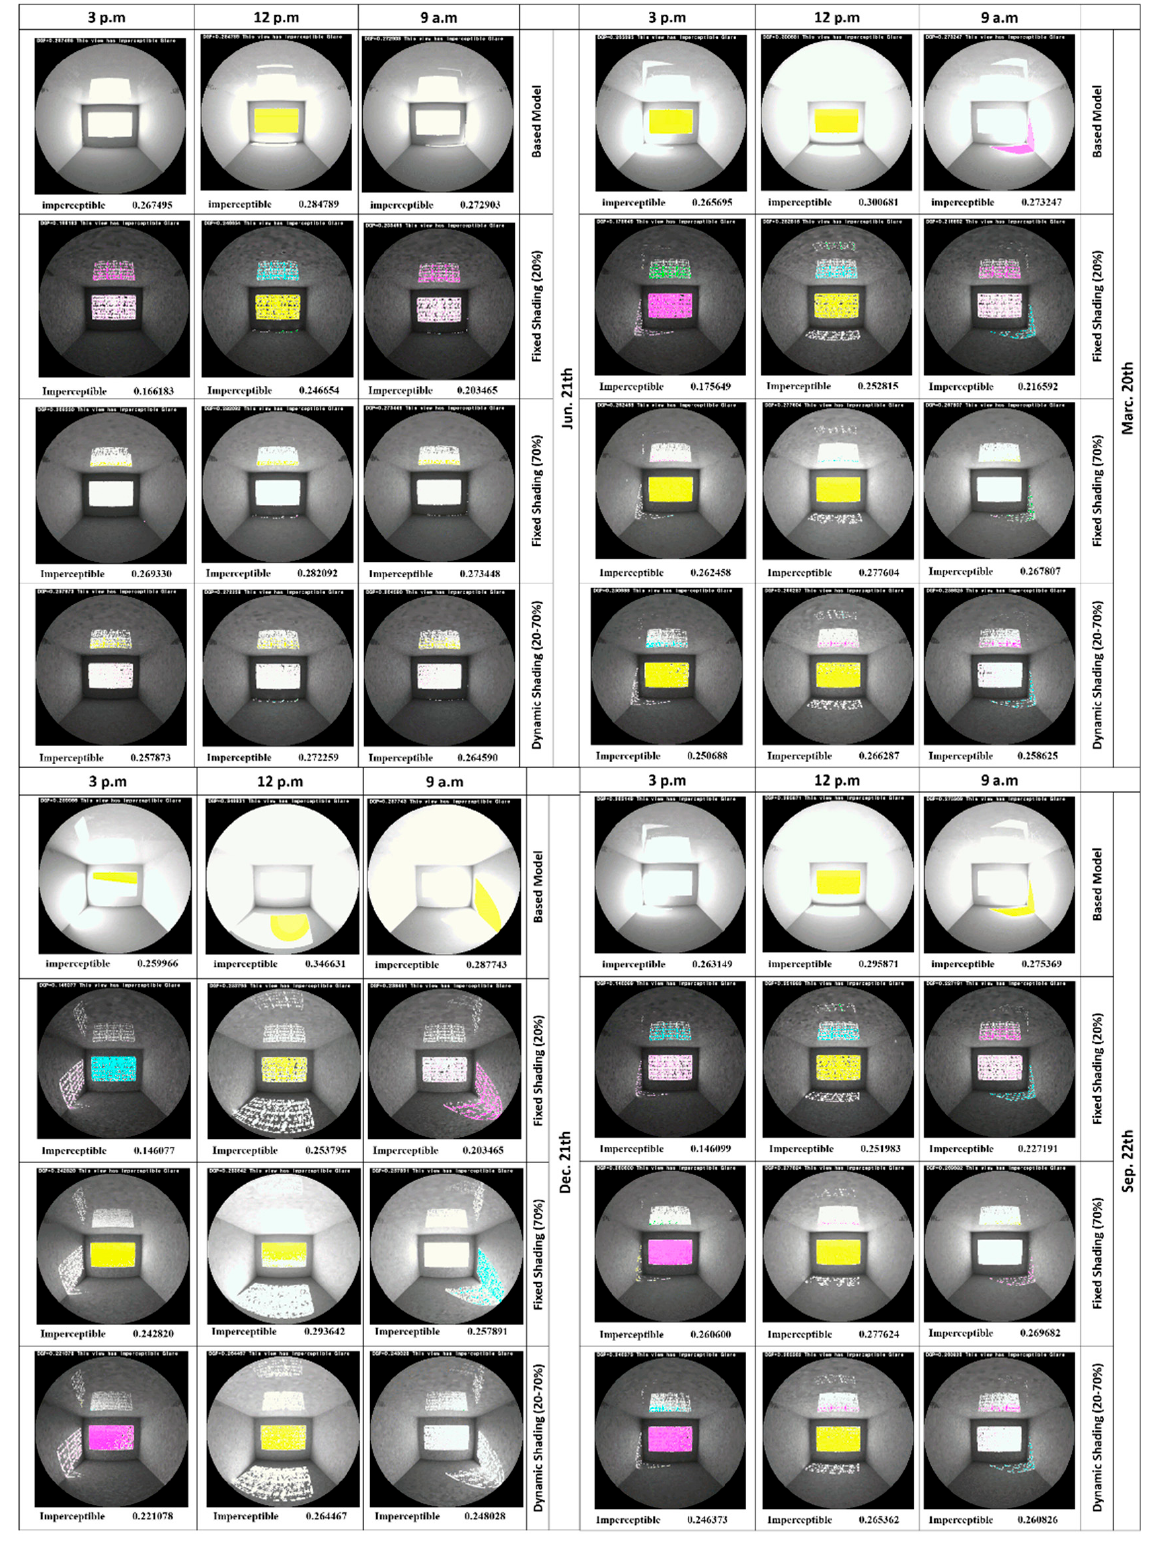
Figure 15. Daylight Glare Index (DGI) analysis.